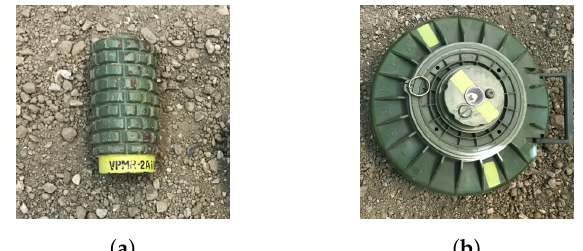
Figure 11. ( a ) Anti-Personnel (AP) metal landmine of size 8 × 17 cm; ( b ) Anti-Tank (AT) plastic landmine of size 27 × 13 cm.